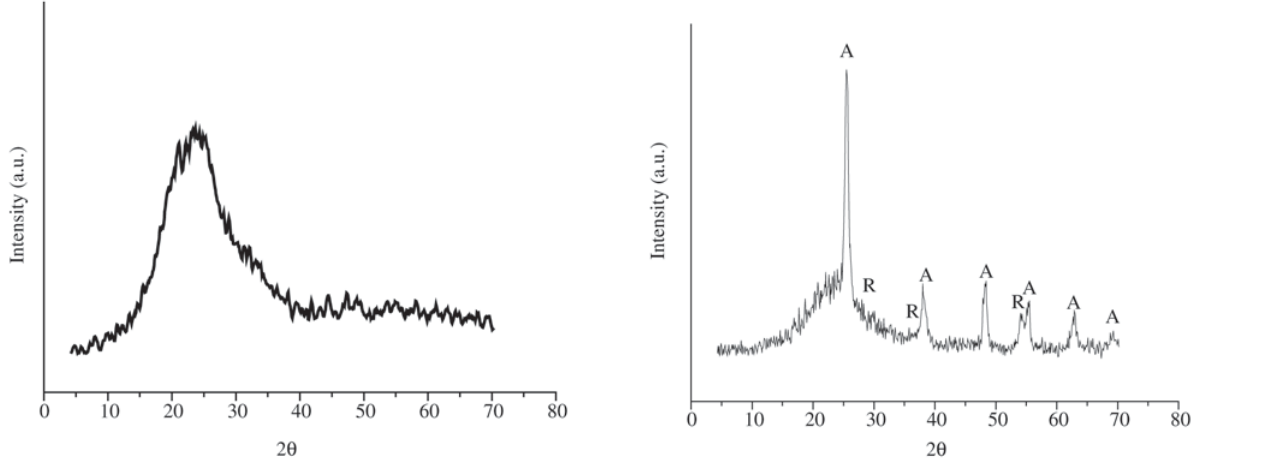
Figure 6. X ray diffraction peaks to STC sample.